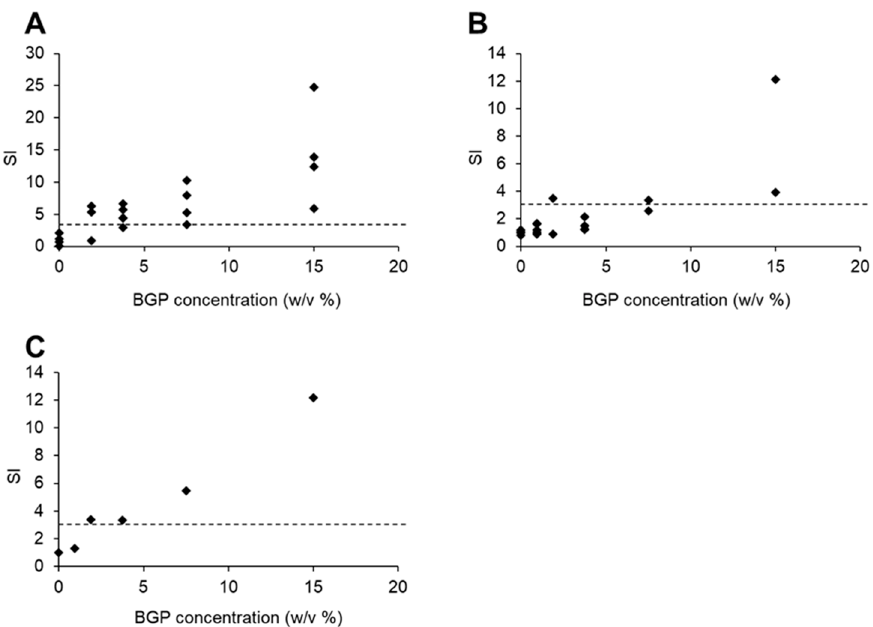
Figure 4. Ear inflammation induced by Brazilian green propolis (BGP). Vehicle or 15.0% ( w / v ) BGP was applied to the back of the ears of mice for 3 consecutive days for LLNA. In LLNA, all mice treated with 15.0% ( w / v ) BGP showed obvious ear inflammation at day 5 from the first exposure. The photos show the typical ears of control mouse (Vehicle; left photo) and inflamed mouse (15.0% BGP; right photo), respectively. Red arrowheads indicate the inflammatory response.